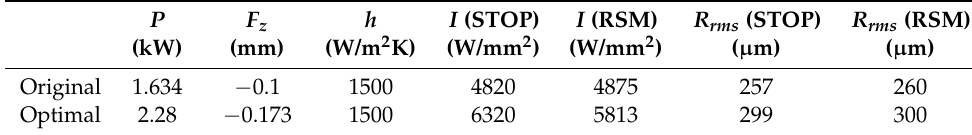
Table 4. Comparison of the original and optimal